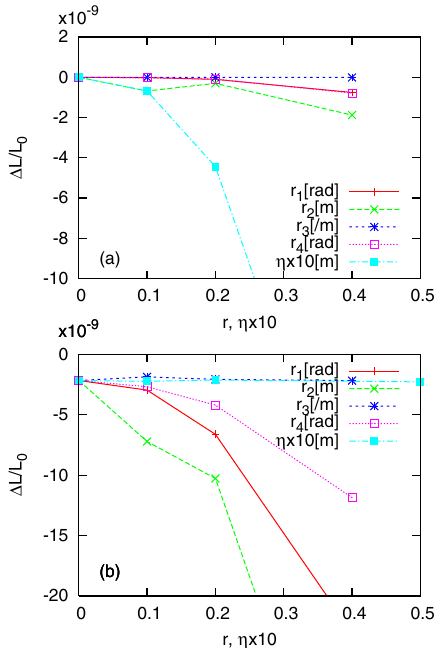
FIG. 14. Luminosity decrement as a function of residual x − y coupling and spurious dispersion, for the cases without 0 . 06 ] (top) and with crossing angle [ θ [ ξ tot ¼ ξ 0 . 038 ] (bottom). The units are r tot ¼ dimensionless for r 1 and r 4